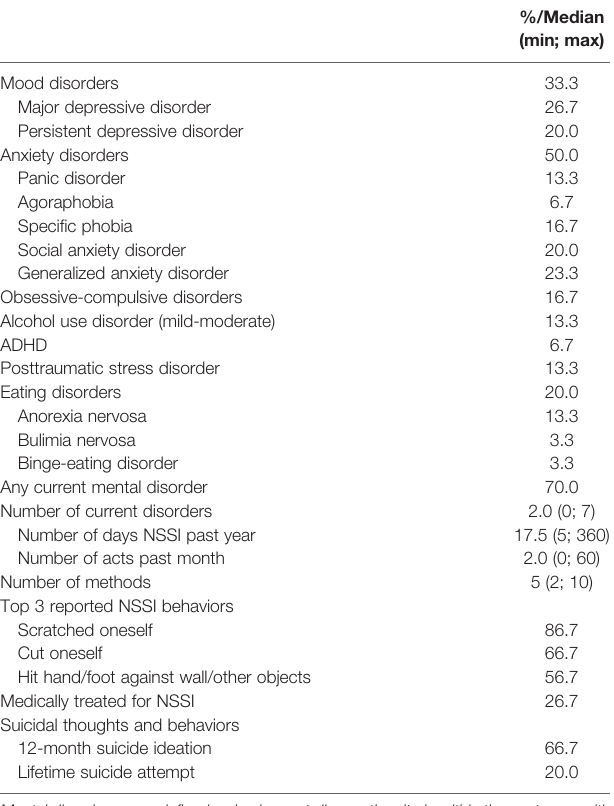
TABLE 1 | Diagnostic characteristics of the sample (n = 30).